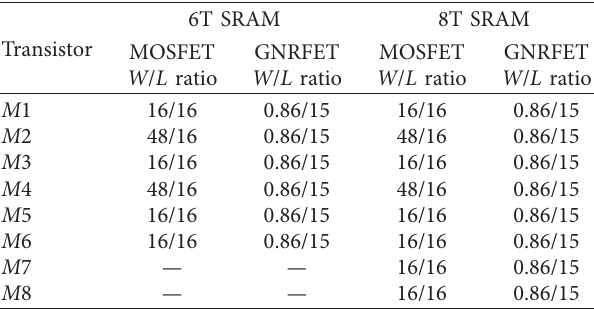
Table 2: Sizing of a structure used for various SRAM